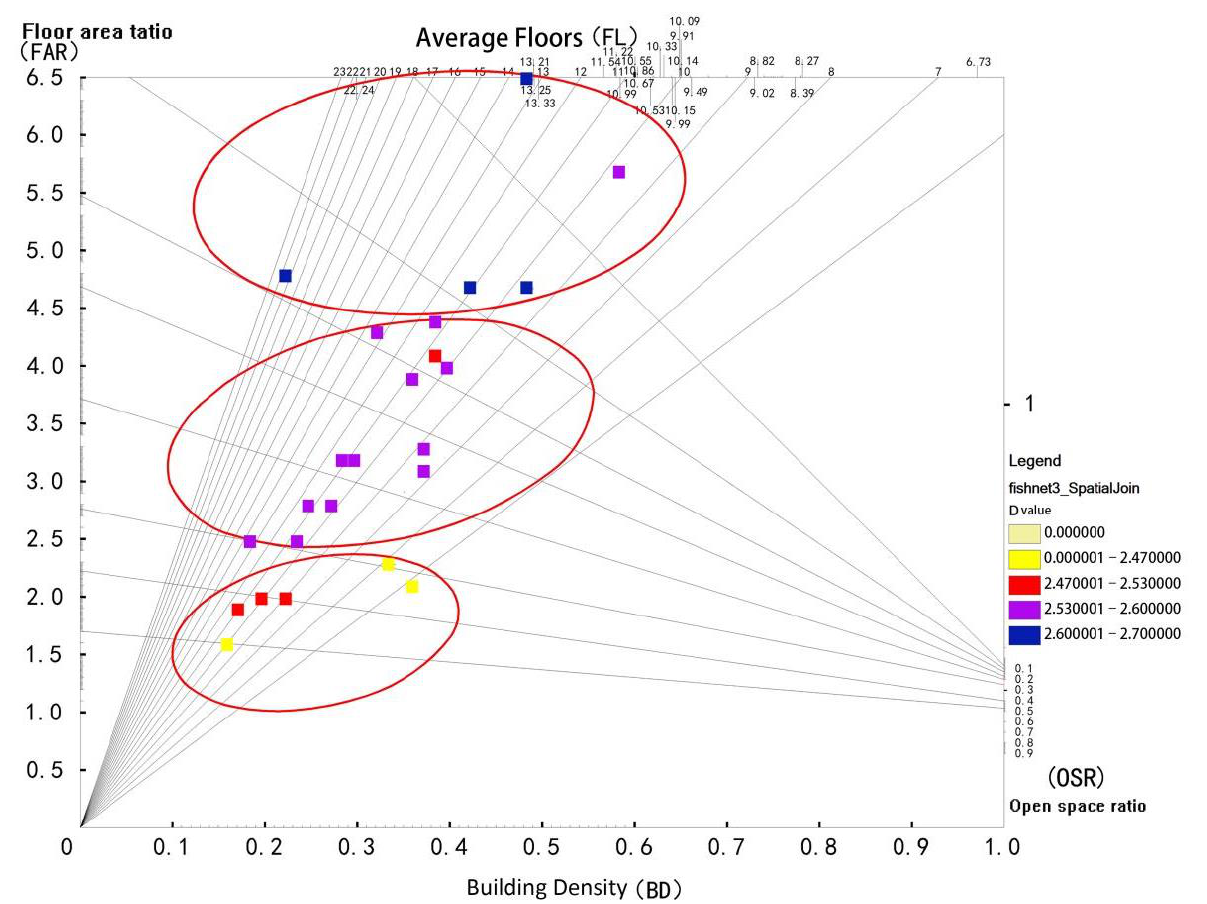
Figure 5. Clustering of 3D D values of sub-research areas. Prepared by the authors.